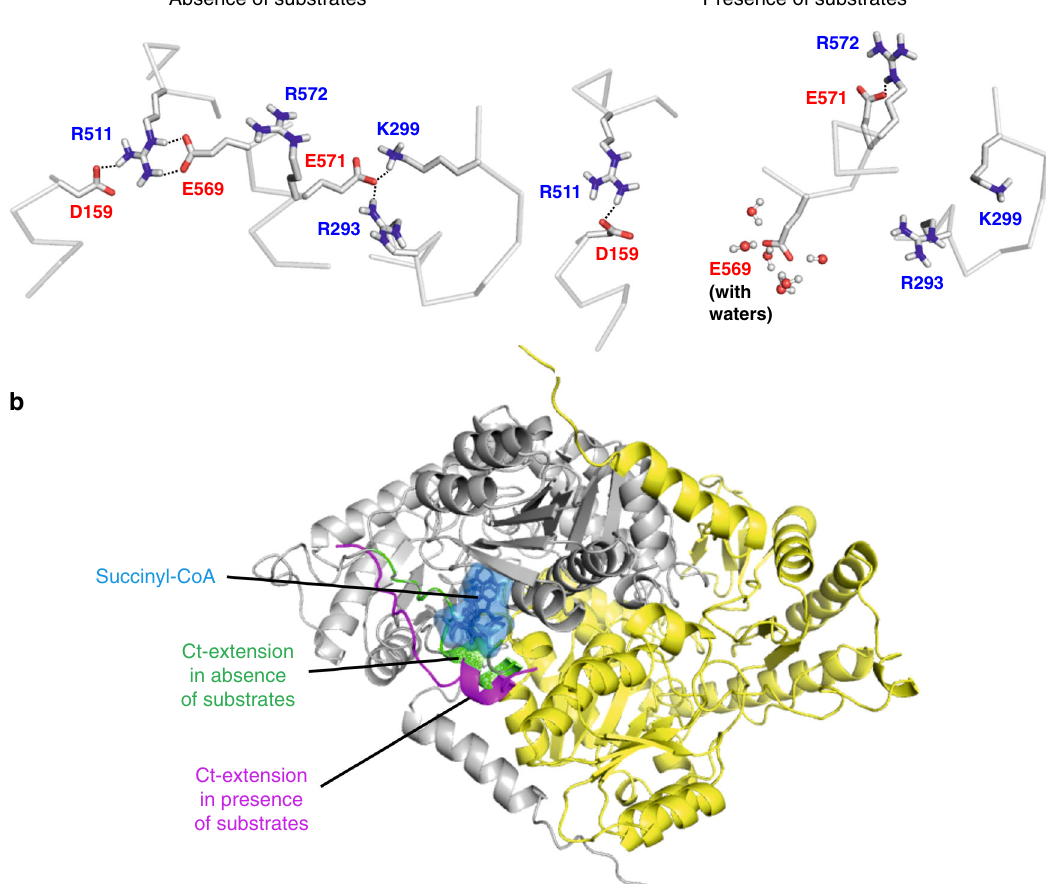
Fig. 4 Dynamics of the Ct-extension revealed by MD simulations. a Salt bridges in the absence (left) and presence (right) of substrates. The structure depicted on the left is the crystal structure subjected to energy minimization, and the structure depicted on the right is a representative snapshot taken from the simulation performed in the presence of substrates. Salt bridges are indicated by dashed lines. Water molecules stabililizing the E569 residue are shown in ball and stick representation. b The orientation of the Ct-extension in the absence and presence of substrates (shown in green and magenta, respectively). The space occupied by succinyl-CoA in the simulated structure is shown in